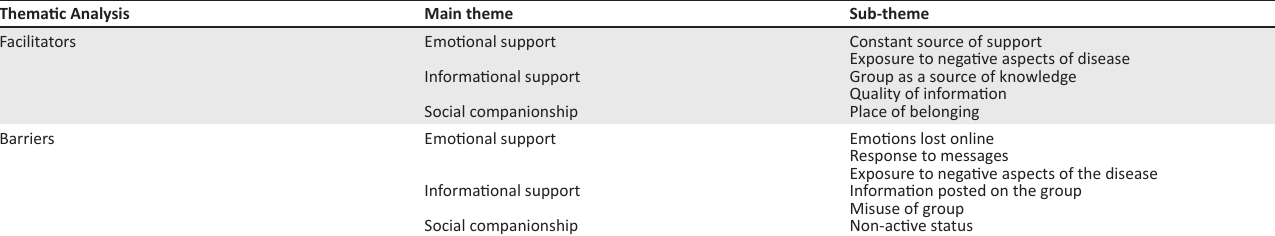
TABLE 1: Themes and their respective sub-themes that were identified during thematic analysis. Thematic